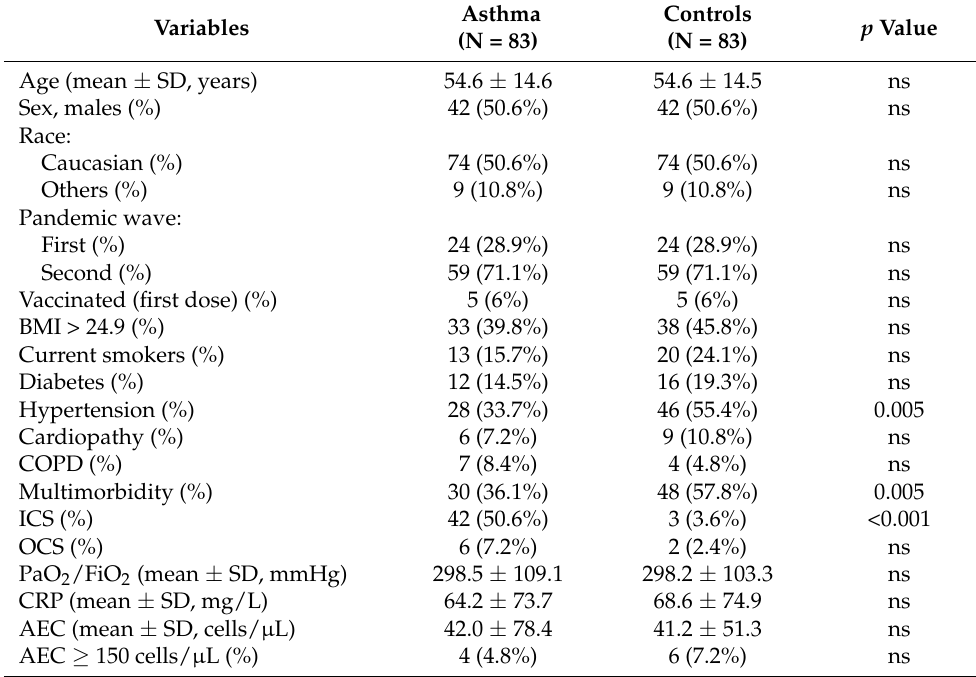
Table 1. Characteristics of cases and controls admitted to our ED for symptomatic COVID-19. Ab-